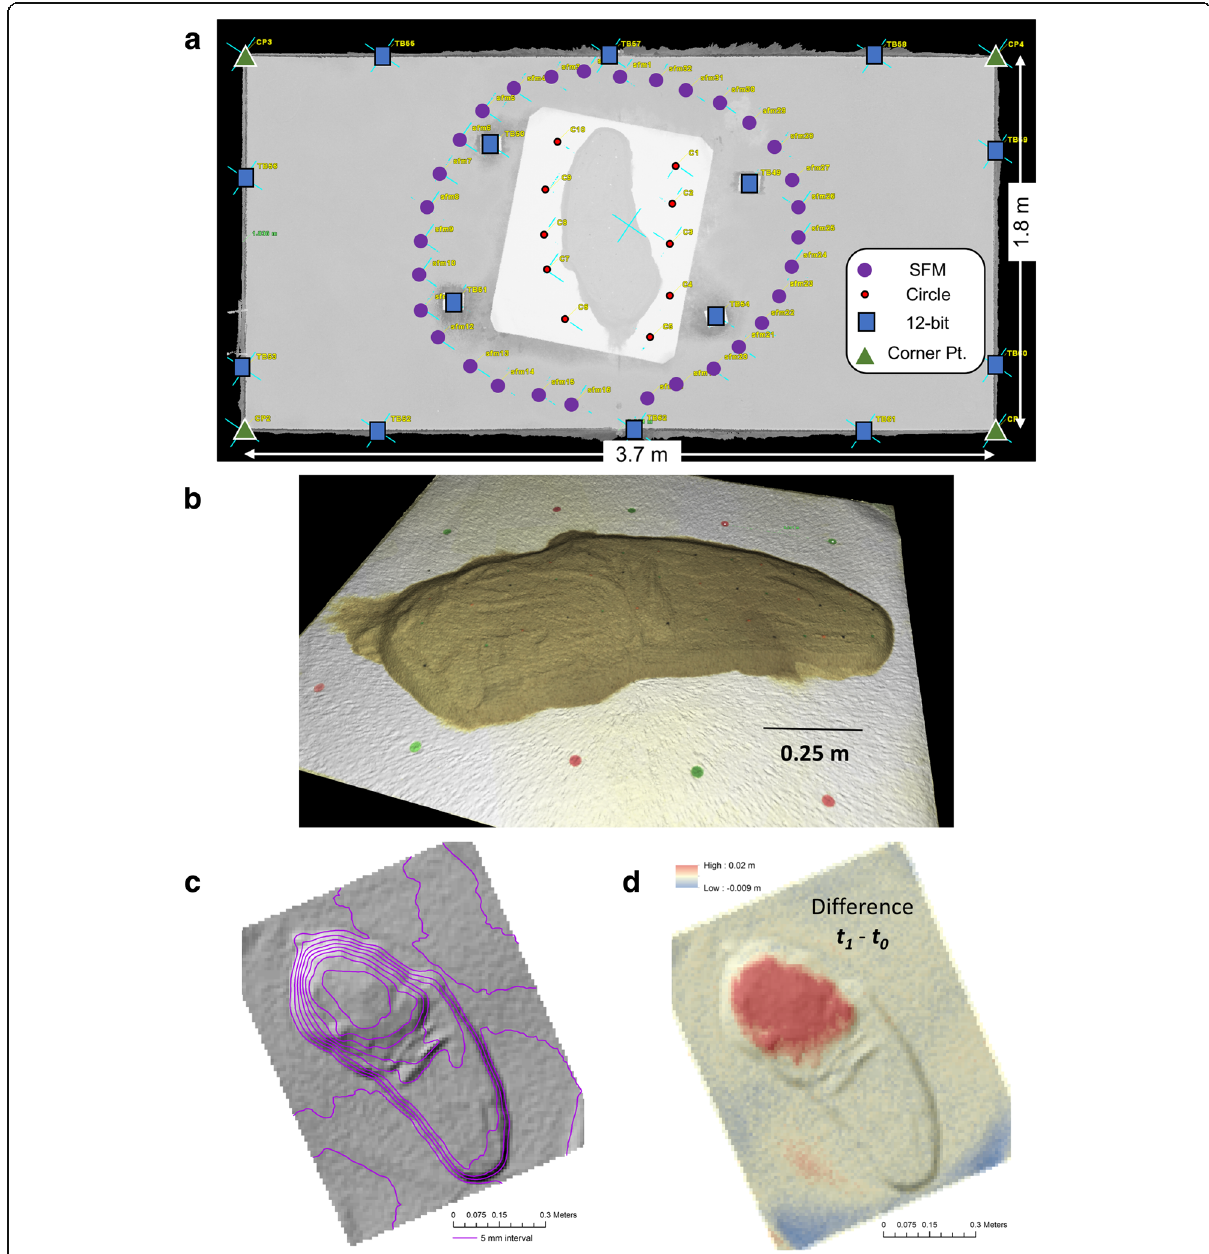
Fig. 6 The experimental fan model. a Location of control points and cameras. b SfM image of the fan on the plotter paper with the circle targets (image rotated 90 CCW to A). c A topographic map of the experimental fan. d Elevation difference from t 1 to t